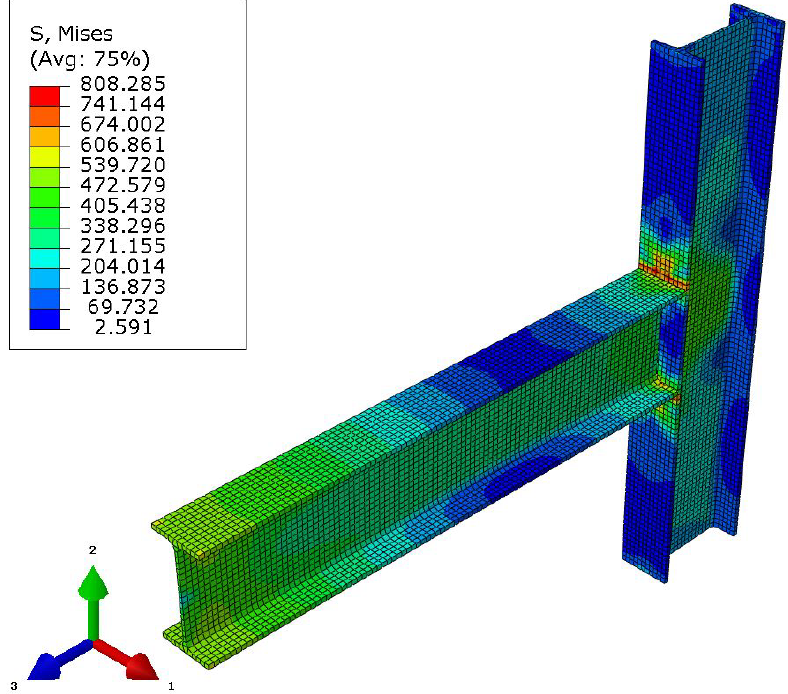
Figure 12. Contour plot of the von Mises stress under monotonic loading for the unstrengthened connection .